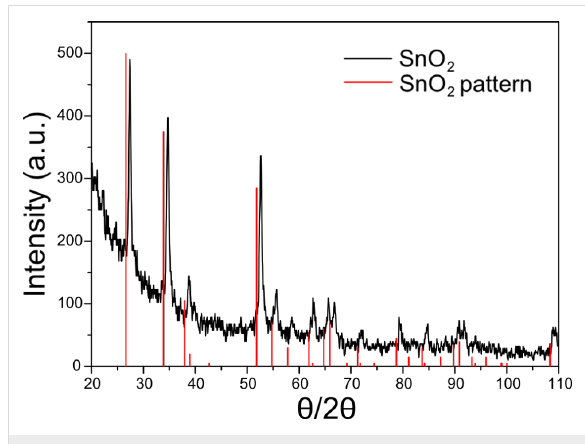
However, nano-sized dimensions are still observed after heating the sample to 450